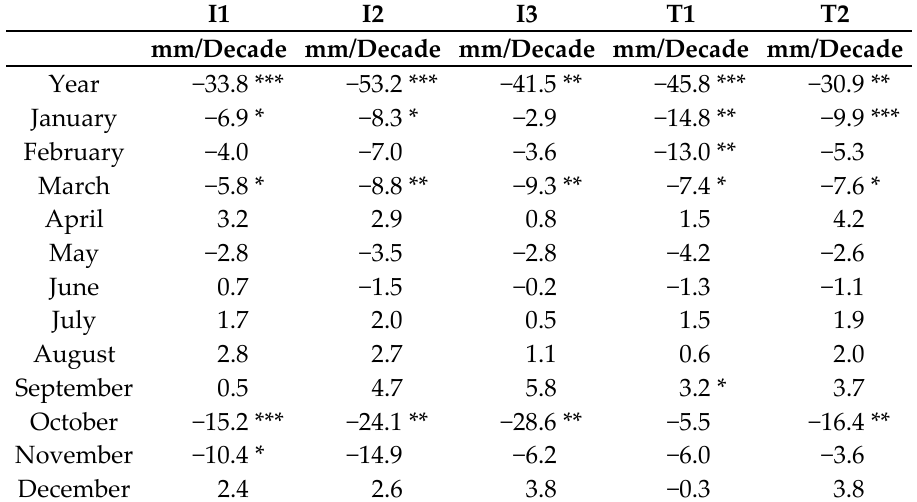
Table 1. Results of the Mann–Kendall test for yearly and monthly precipitation. Asterisks indicate